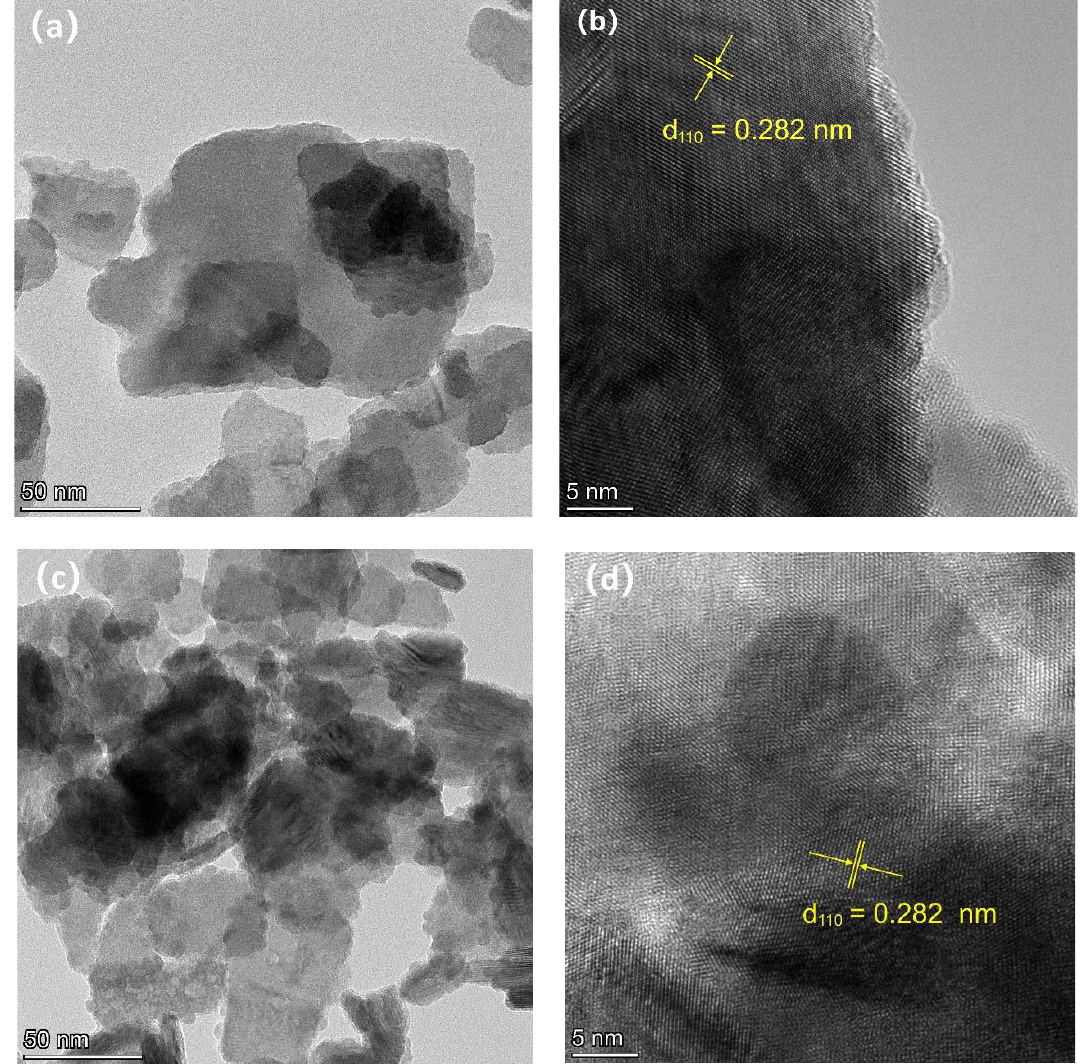
Figure 3. TEM images of BiOBr 0.85 I 0.15 , ( a , b ); 1.0% Ag/BiOBr 0.85 I 0.15 , ( c , d ).